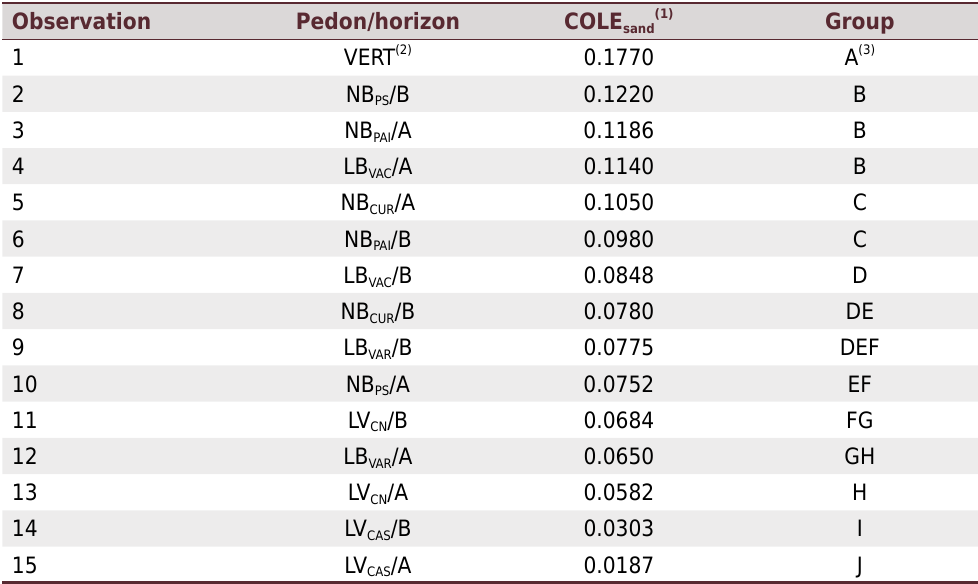
Table 4. Division of shrinkage intensity groups (COLE sand ), through cluster analysis by error estimation